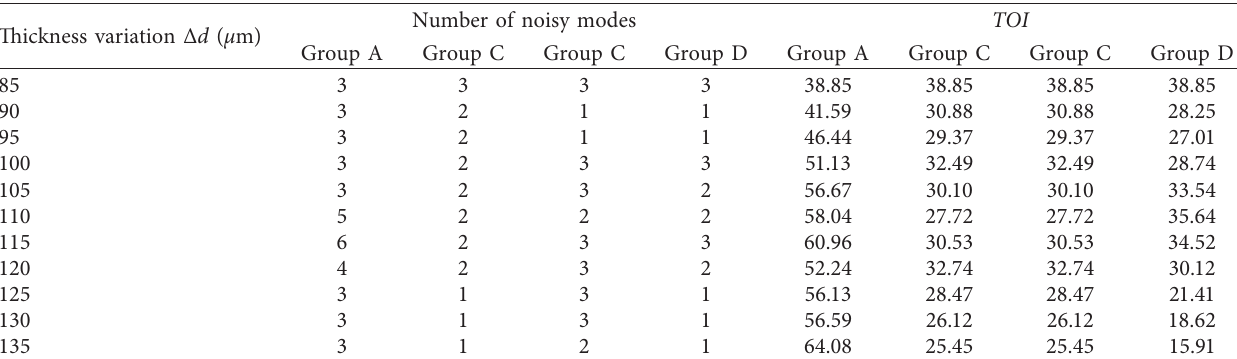
Table 5: Number of noisy modes in Groups A-D and the corresponding TOI . Thickness variation Δ d ( μ